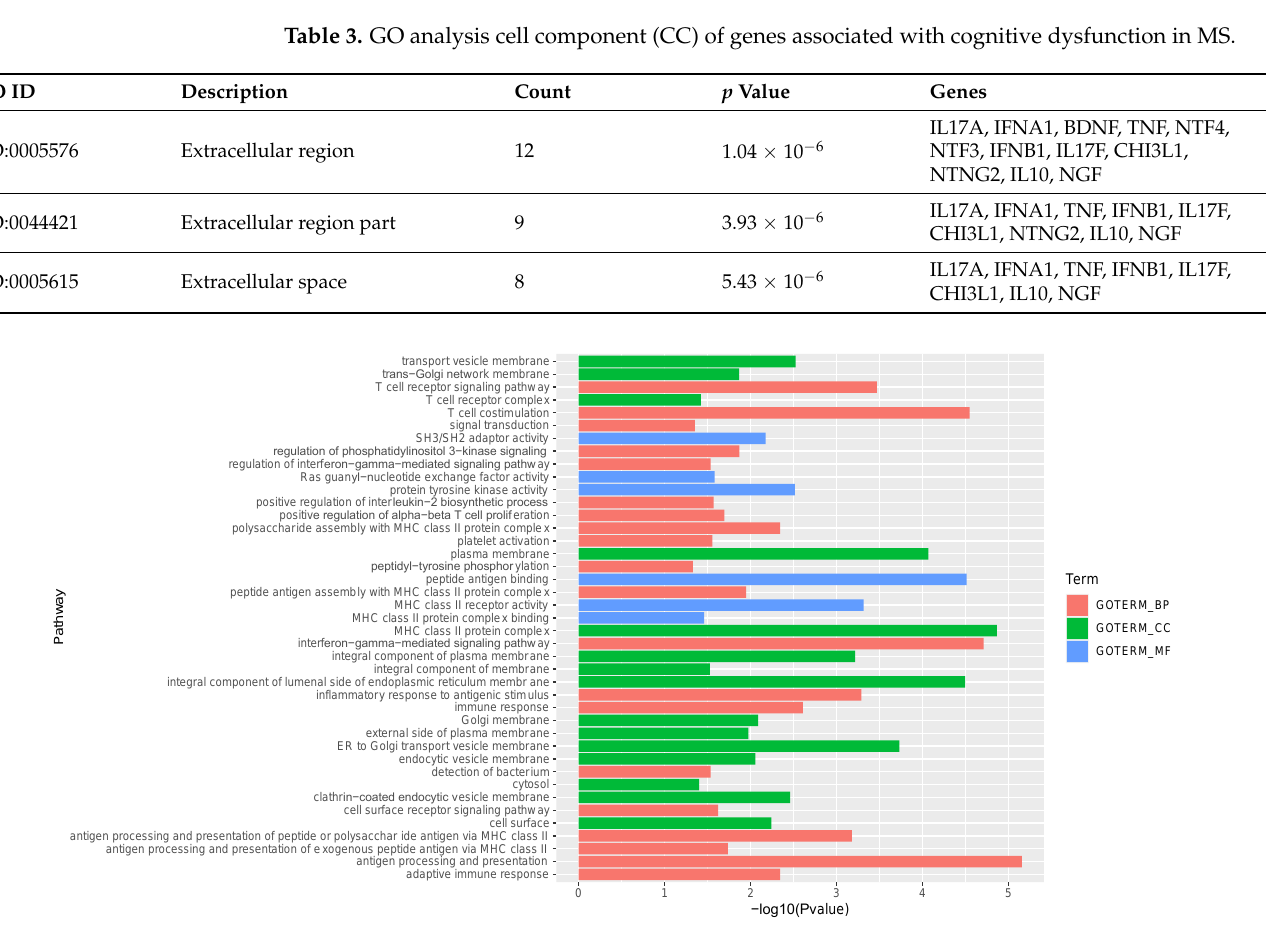
Figure 2. The X and Y -axes represent pathways (GO Terms) and the −log 10 p- value of the corre- sponding GO term, respectively. GO terms are represented as follows: BP (biological process), CC (cellular component), and MF (molecular function).